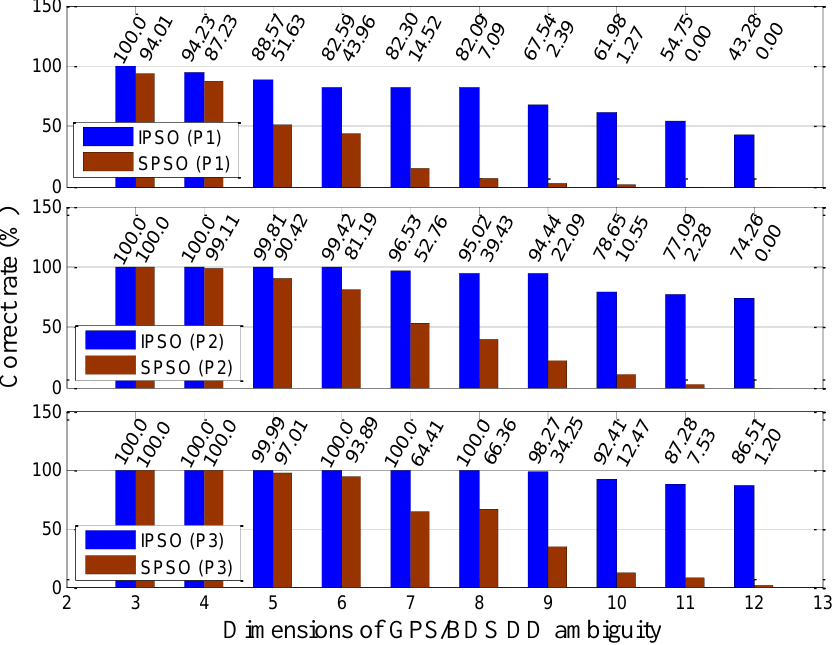
Figure 10. Correct rates of IPSO/SPSO–AR under various DD ambiguity dimensions in Scheme #3.